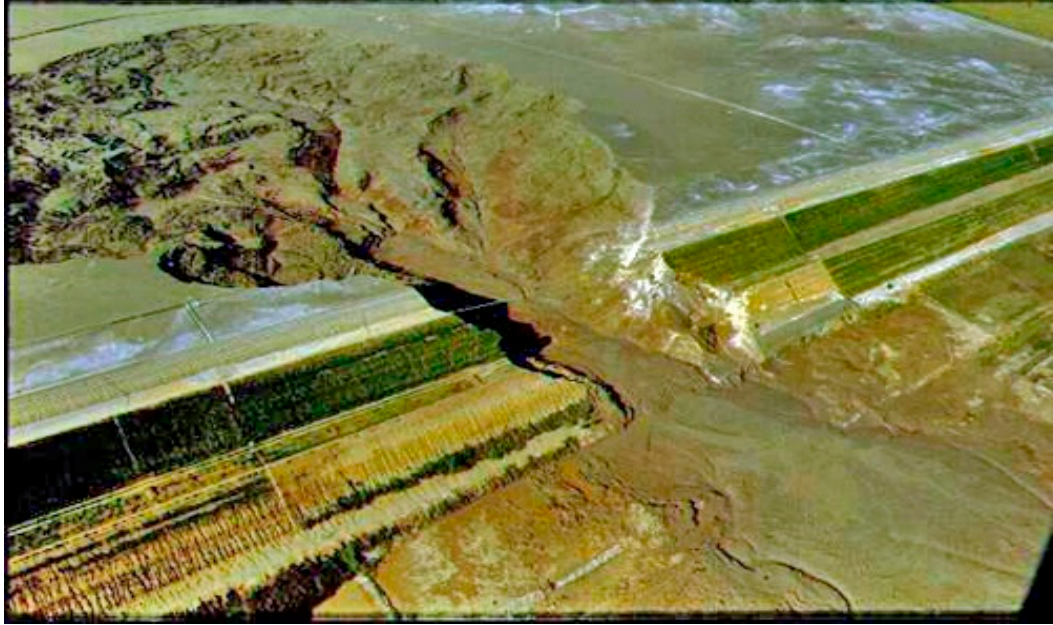
Figure A1. Aerial view of the Merriespruit tailings dam disaster. Approximate volume of the dam = 2.5 million cubic meters. Source: Tailings.info. Available online: http://www.tailings.info/casestudies/ merriespruit.htm (accessed on 26 March